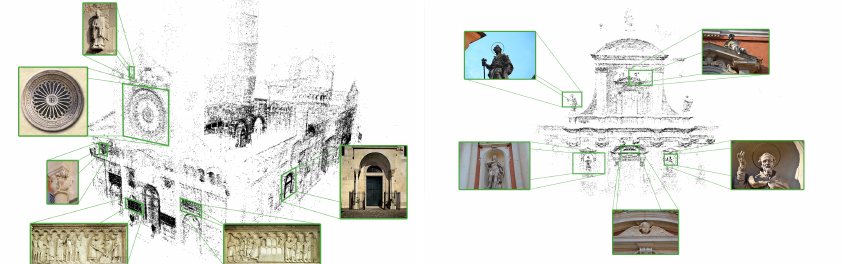
Figure 3. 3D reconstruction and relevant details of Cathedral and San Giorgio’s Church in Modena